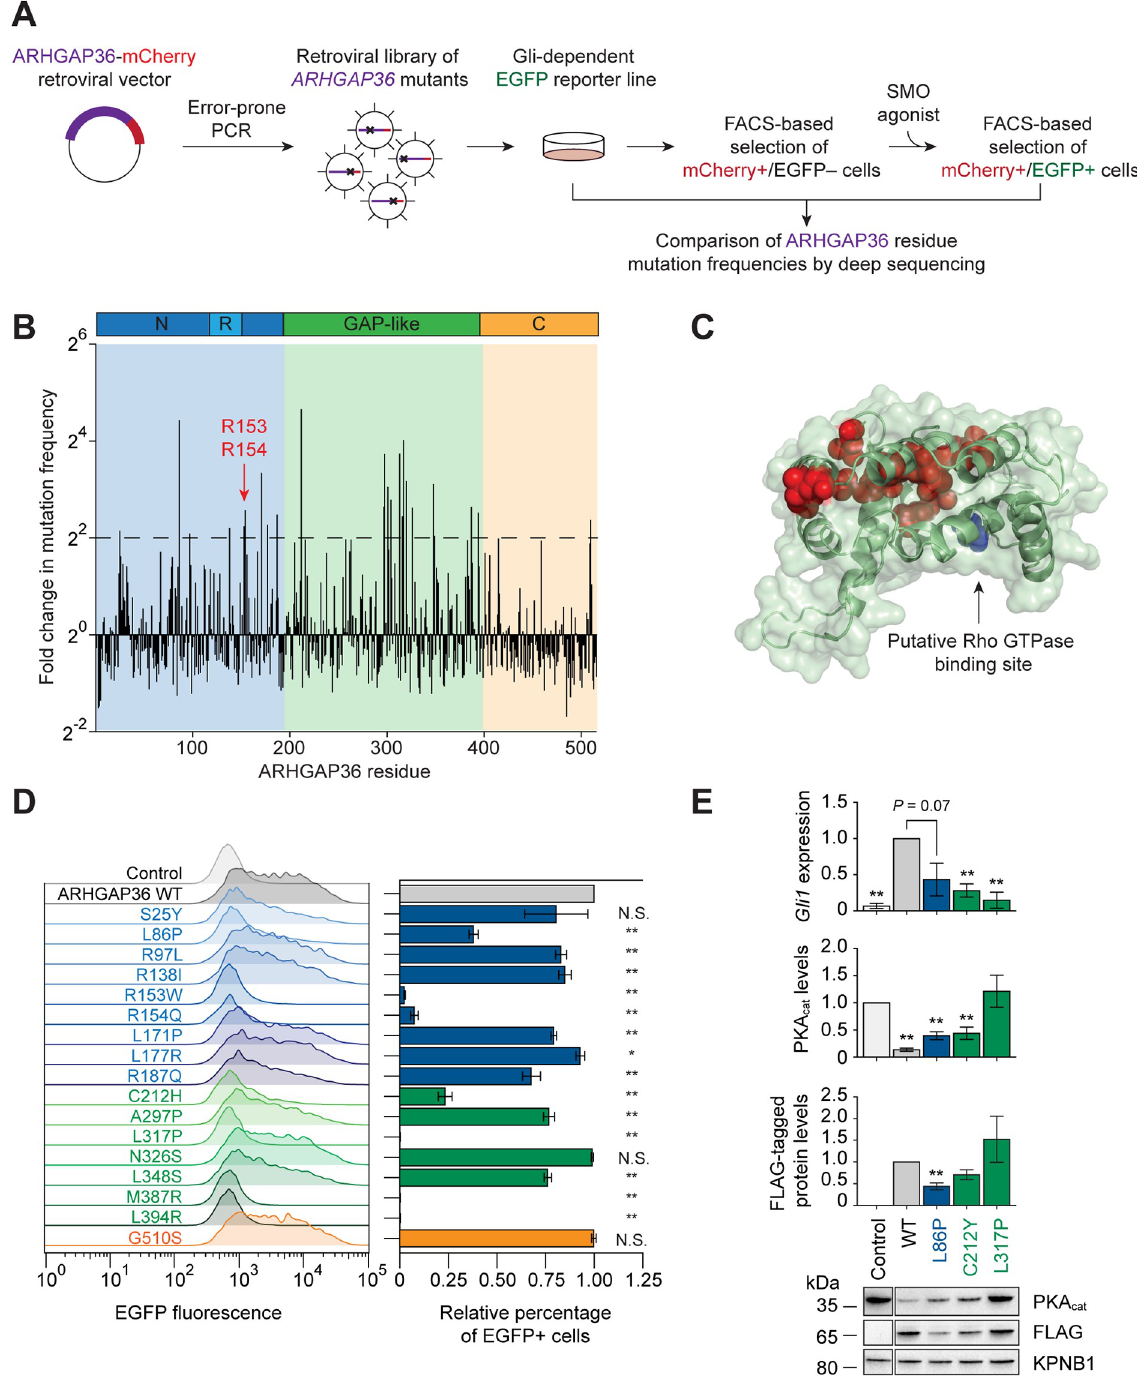
Fig 2. Identification of essential residues within the N-terminal and GAP-like domains. (A) Schematic representation of the high- throughput mutagenesis screen used to identify individual residues that contribute to ARHGAP36 function. (B) Histogram depicting the fold change in mutation frequency between pre- and post-selected populations for each ARHGAP36 residue. (C) Homology model of the GAP-like domain based on the β 2-chimaerin crystal structure (PDB ID: 1xa6). Residues with > 4-fold change in mutation frequency are shown in red, and the site that is structurally equivalent to the arginine finger (Thr227) is shown in blue. (D) Activities of selected ARHGAP36-mCherry variants in SHH-EGFP cells, as assessed by flow cytometry. mCherry fluorescence intensities were used to gate cells with comparable levels of ARHGAP36 expression, and the distributions of EGFP fluorescence (left) and relative percentage of EGFP+ cells (right) are shown for each ARHGAP36 construct. Data are the average fold change in percentage of EGFP+ cells relative to that of cells expressing wild-type ARHGAP36